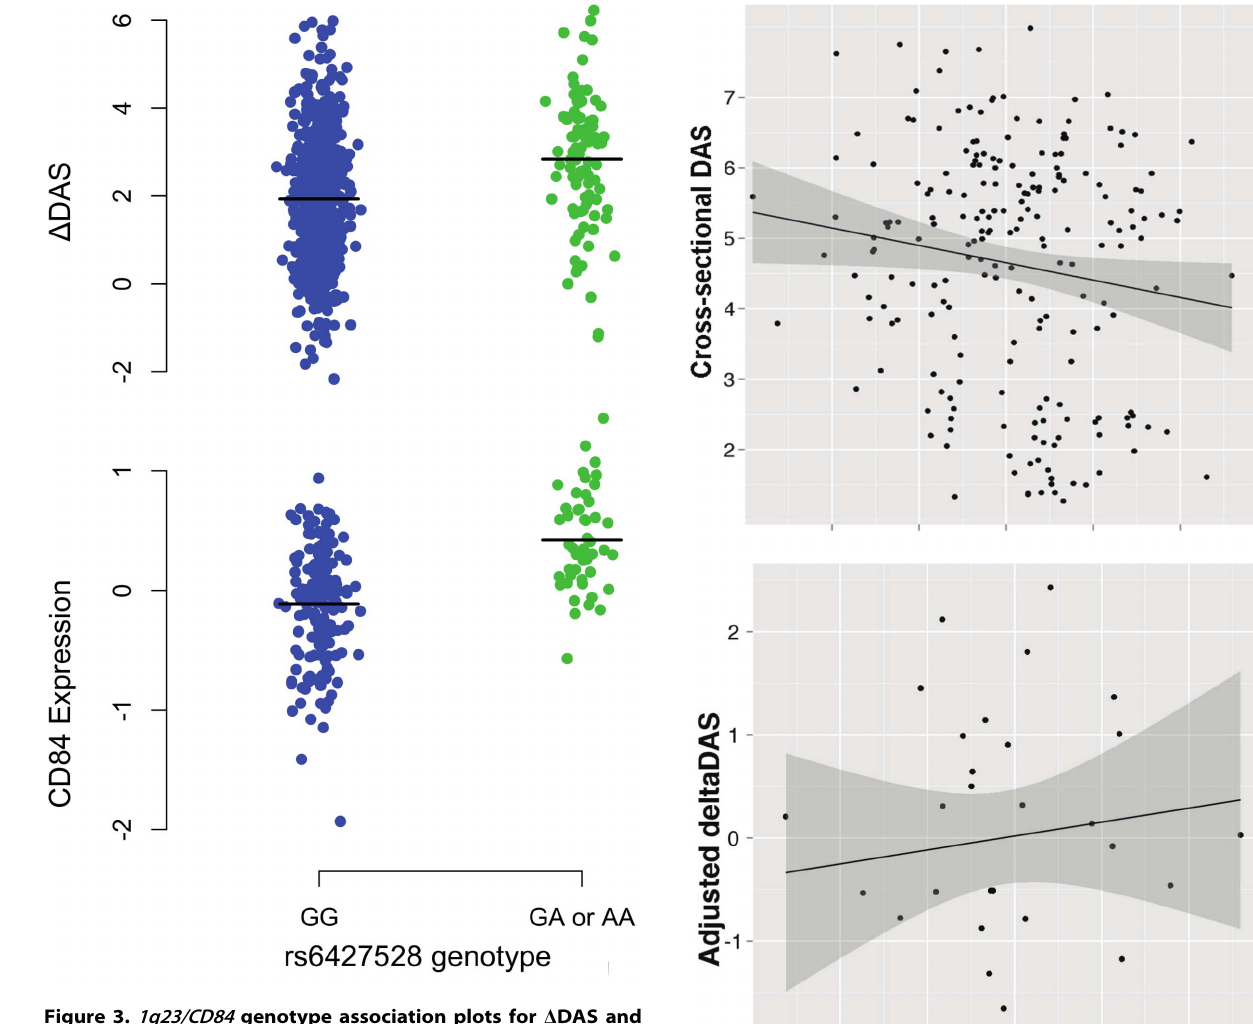
Figure 3. 1q23/CD84 genotype association plots for D DAS and CD84 gene expression. Shown are D DAS in our GWAS in etanercept- treated patients (top panel, n=733; n=634 with the GG genotype and n=99 with the GA or AA genotype) and CD84 expression in our eQTL results (bottom panel, n=228 non-RA patients; n=178 with the GG genotype and n=50 with the GA or AA genotype). The rare-allele homozygous genotype AA was observed four times in our D DAS GWAS and was pooled with the heterozygous GA genotype for this figure; AA homozygotes were not observed in the CD84 eQTL data. Association analyses reported in the text regressed phenotype ( D DAS, P=8 6 10 2 8 ; CD84 expression, P=1 6 10 2 11 ) on minor-allele dosage (range 0–2).